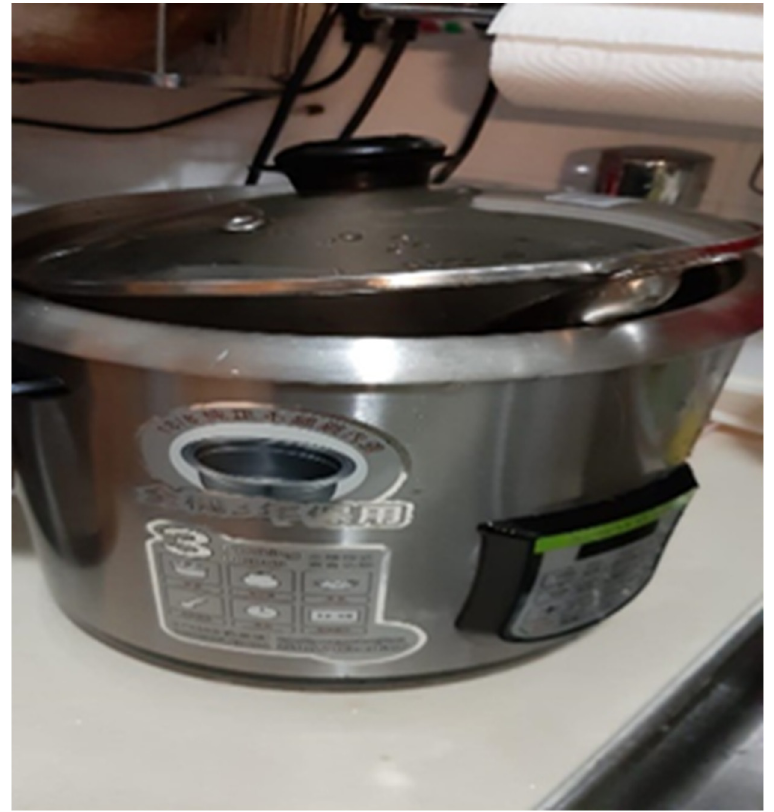
Figure 12. Photograph by Participant E.